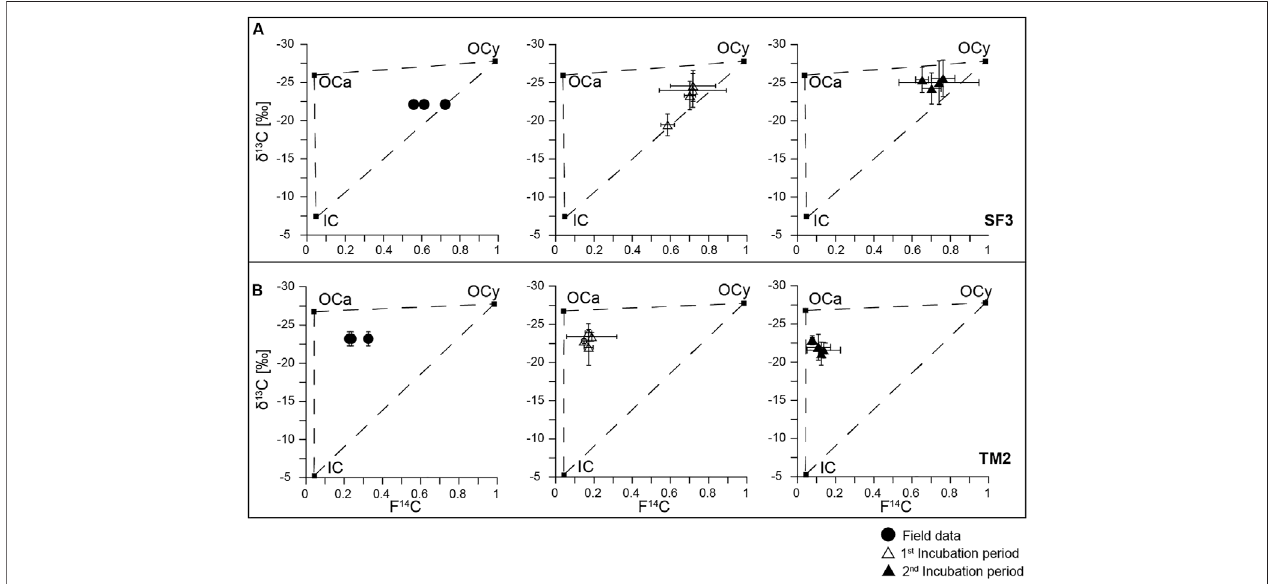
FIGURE 3 | Carbon isotope biplots for (A) SF3 and (B) TM2 indicating endmembers (squares) on which the three-pool mass balance approach is based and including fi eld and incubation data (mean values of depth intervals and standard deviation).